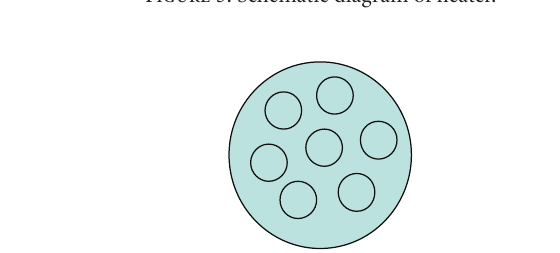
Figure 5: Schematic diagram of heater.